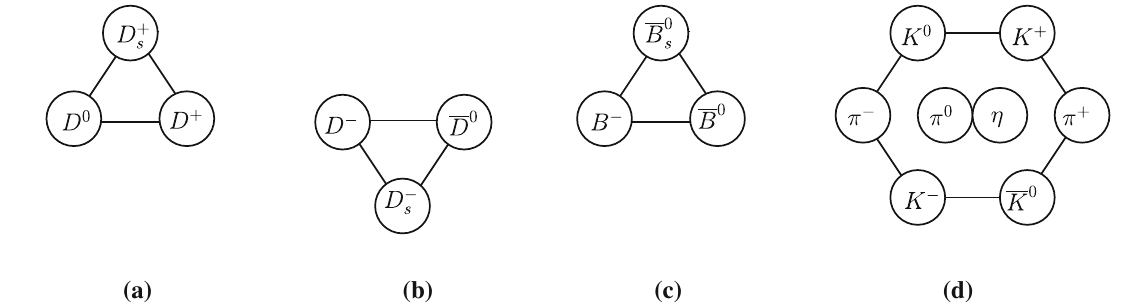
Fig. 1 The weight diagrams for the anti-charmed meson triplet, charmed meson anti-triplet, bottom meson triplet and light meson octet